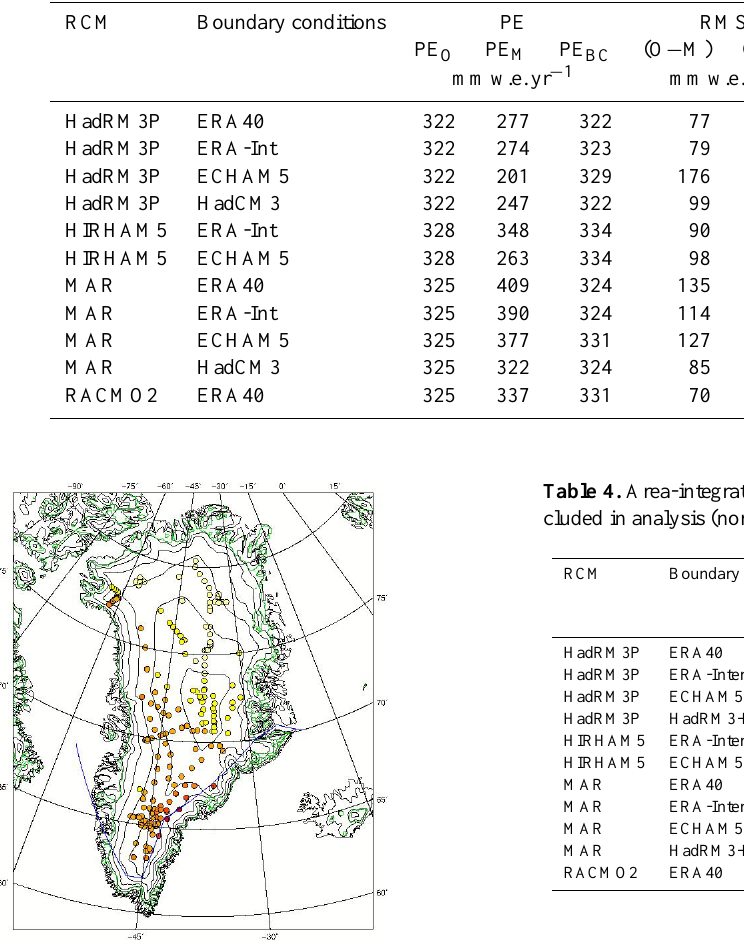
Table 3. Comparison between PE observations and modelled values (weighted means over all observing sites). The root square mean error (RSME) is between the observations and model output (O − M) and bias corrected model output (O − BC).